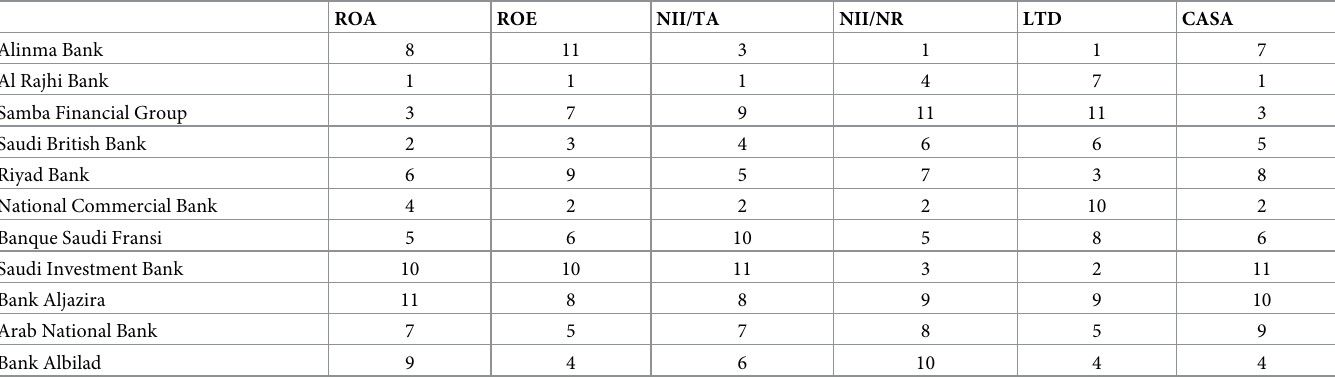
Table 2. Ranks of Saudi banks using CAMEL composites (E, L).